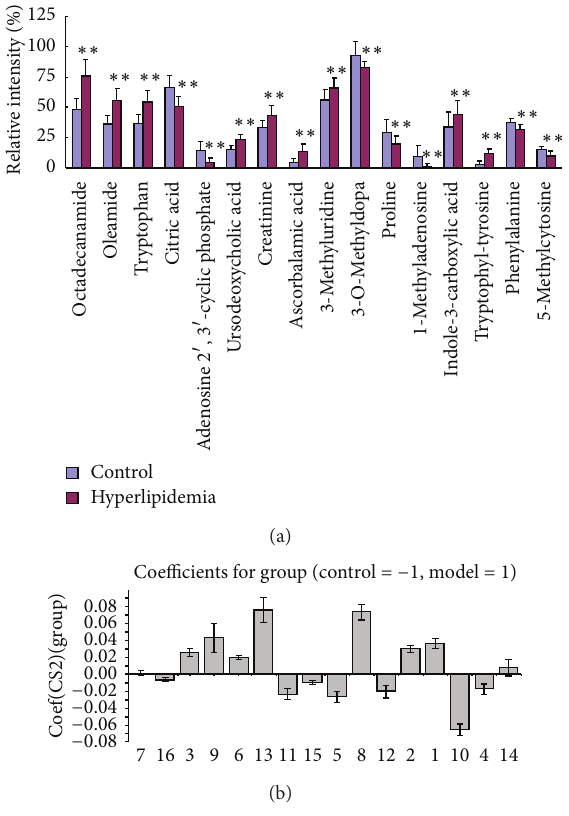
Figure 3: (a) Comparison of the relative intensity and (b) OPLS- DA loading plot of putative potential biomarkers in control and diet-induced hyperlipidaemia rats. The loading plots represent which metabolites are quantitatively higher or lower in diet-induced hyperlipidaemia rats compared with control rats. Numbers consist with Table